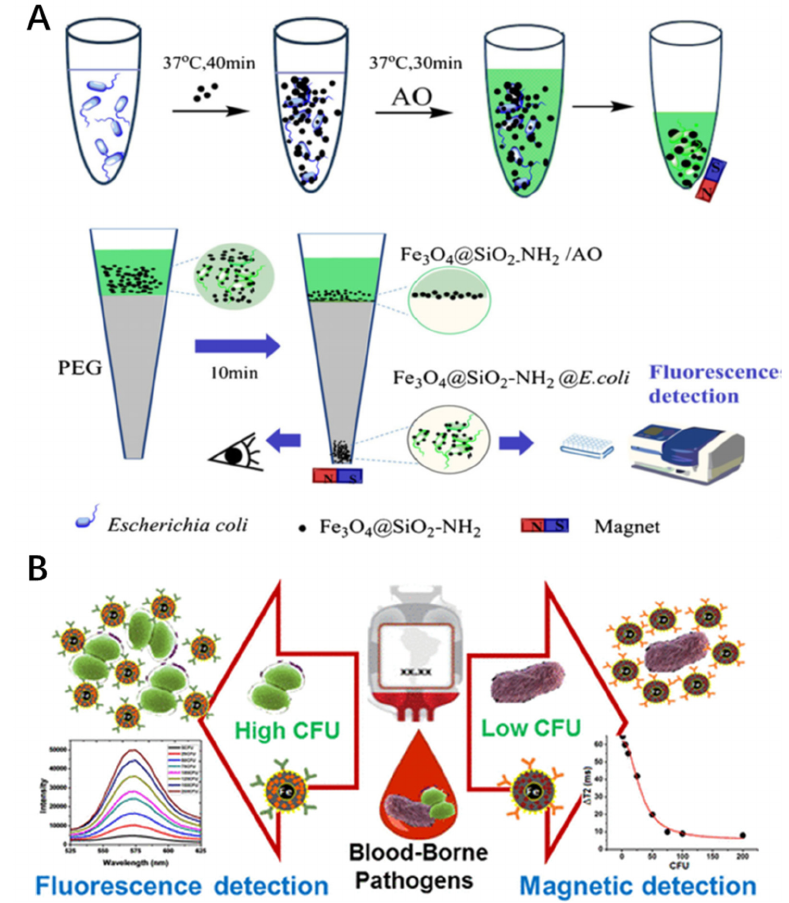
Figure 2. Schematic illustration of experimental procedures: ( A ) rapid fluorescence detection of pathogenic bacteria using a magnetic enrichment technique combined with magnetophoretic chro- matography (reproduced with permission from [47]; published by Springer, 2017); ( B ) multimodal magneto-fluorescent nanosensor for rapid and specific detection of blood-borne pathogens (repro- duced with permission from [48]; published by American Chemical Society, 2019).